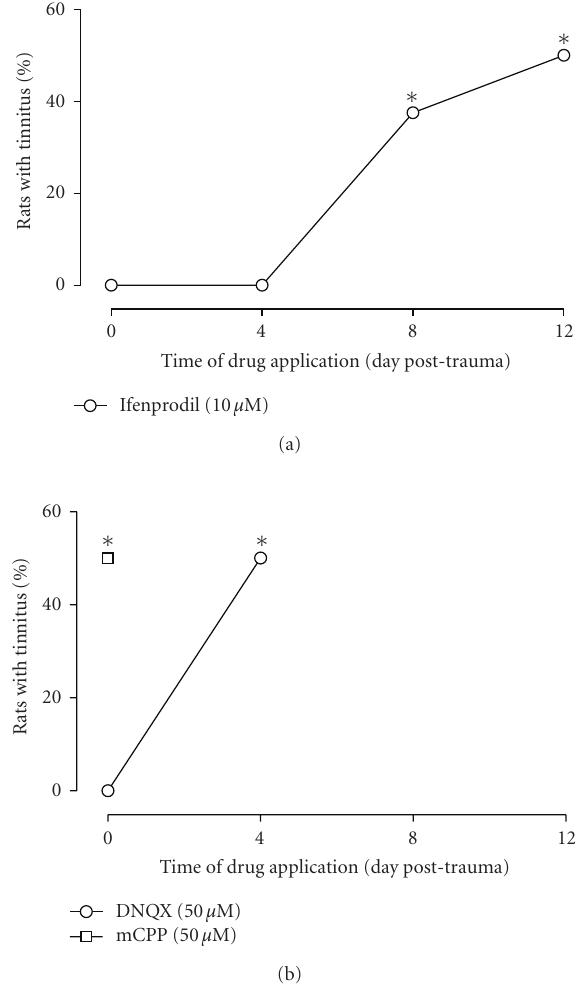
Figure 4: E ff ect on tinnitus of cochlear application of glutamatergic antagonists as a function of time after noise overexposure. Depicted is the proportion of animals experiencing tinnitus, as evident in the WTM test, 2 weeks after sound overexposure. Day 0 corresponds to drug application performed just before sound overexposure. (a) E ff ect of local cochlear application of ifenprodil as a function of time. When applied just before sound overexposure, none of the animals displayed tinnitus when tested 2 days later. Similar results were obtained when ifenprodil was applied 4 days after sound overexposure. However, when ifenprodil was applied 8 or 12 days after sound overexposure, about 50% of the rats experienced tinnitus (not di ff erent from the proportion observed in the group that underwent sound overexposure, chisquare test ( ∗ P < .05 compared to the group of animals receiving ifenprodil at day 0, Wilcoxon test)). (b) E ff ect of DNQX and mCPP. When applied just before sound overexposure, DNQX totally prevented the occurrence of tinnitus 2 weeks afterwards. However, when applied 4 days after sound overexposure, no protective e ff ect was evident. Application of mCPP just before sound overexposure did not modify the proportion of rats experiencing tinnitus ( n = 8 each, ∗ P < .05 compared to the group of animals receiving ifenprodil at Day 0, Wilcoxon test).